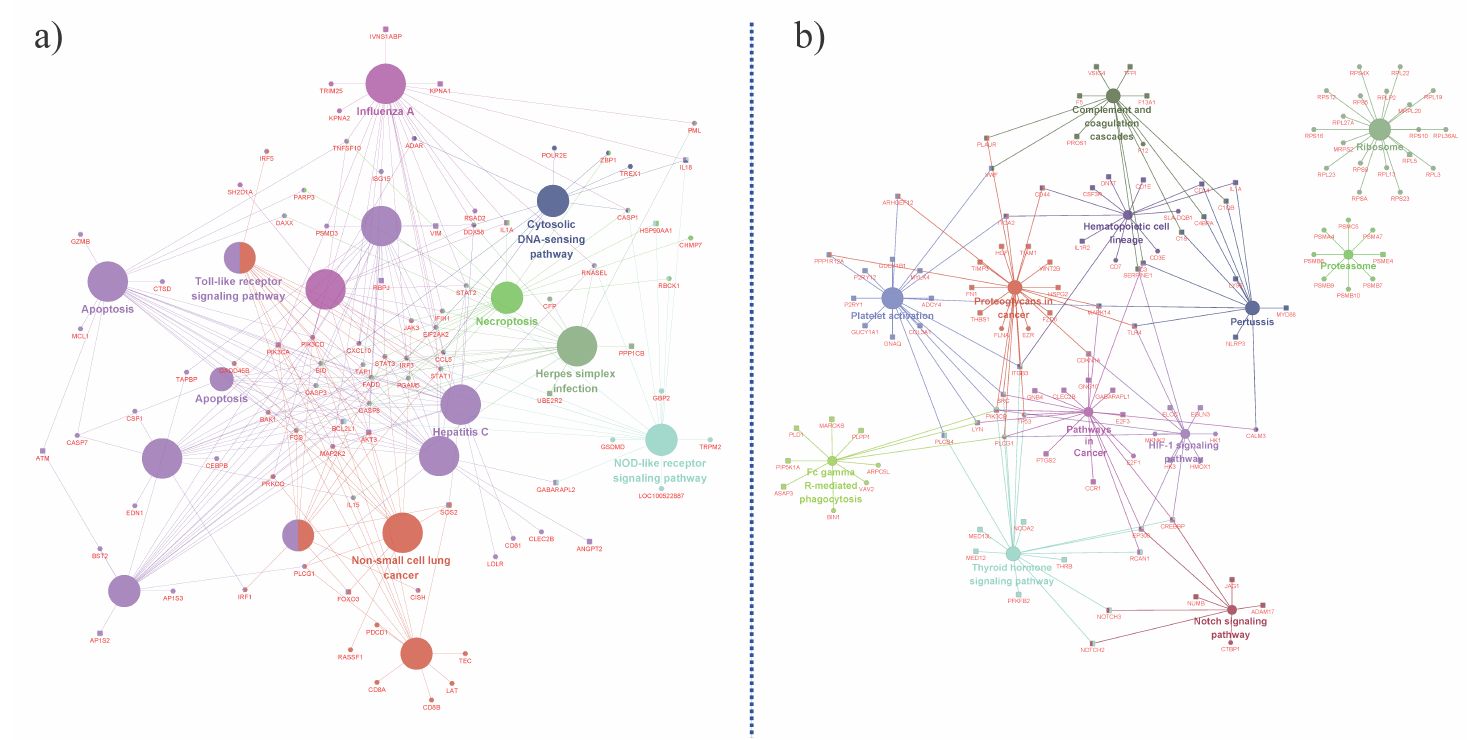
Figure 3. KEGG pathway enrichment analysis: ( a ) enriched KEGG pathways in female group; ( b ) enriched KEGG pathways in male group. Nodes are genes and edges represent pathways. Up-regulated genes are represented as rectangles and down-regulated genes are represented as